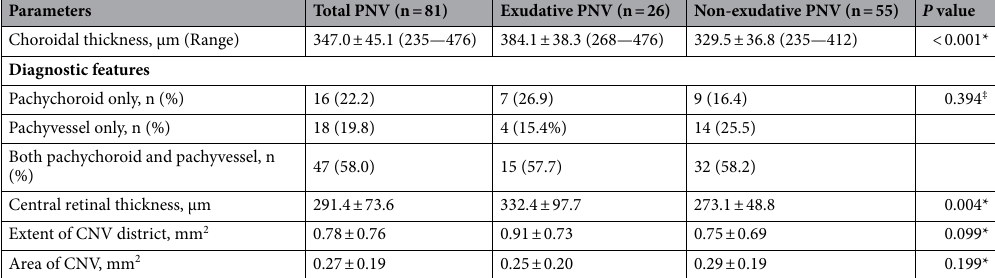
Table 2. Baseline features of OCT and OCTA. OCT, optical coherence tomography; OCTA, optical coherence tomography angiography; PNV, pachychoroid neovasculopathy; CNV, choroidal neovascularization. Continuous variables are reported as mean value (± SD). *Mann whiney test; † Independent t -test; ‡ chi-square test.